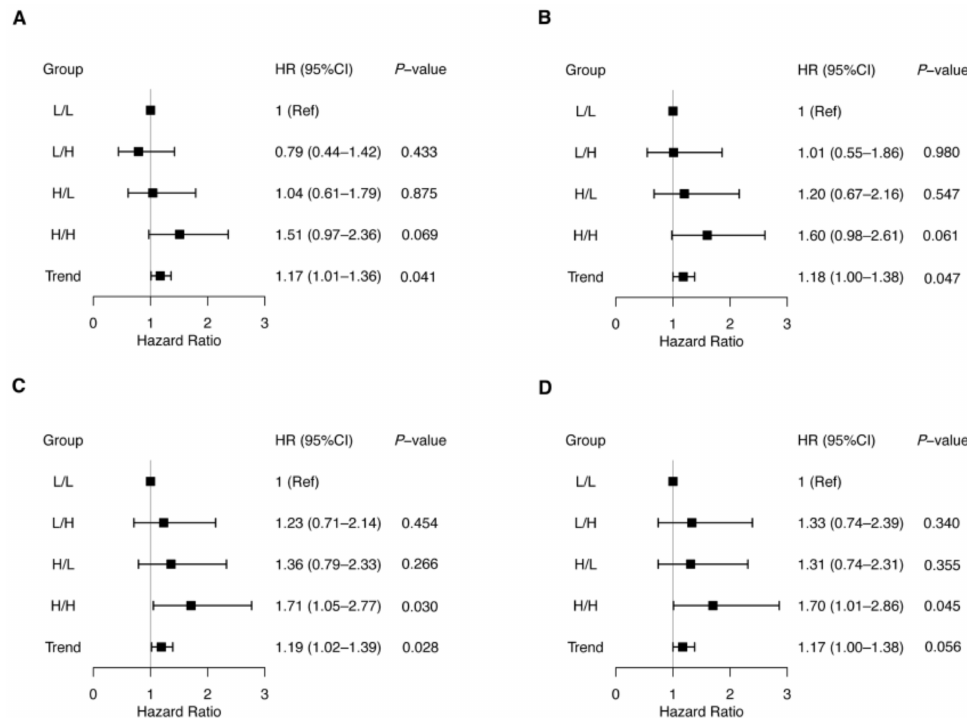
Figure 2. Forest plot of hazard ratios for major adverse cardiovascular events in groups according to trimethylamine N-oxide (TMAO) ( A , B ) and choline ( C , D ) levels at enrollment (V1) and follow-up visit (V2). Patients with available TMAO and choline levels of V1 and V2 were divided into four groups according to the median levels of each visit (TMAO: 6.7 µ mol/L and 12.7 µ mol/L, choline: 1.2 µ mol/L and 1.7 µ mol/L for V1 and V2, respectively). L/L, low V1 and low V2; L/H, low V1 and high V2; H/L, high V1 and low V2; H/H, high V1 and high V2. Cox proportional hazards regression was used to compare the risk of major adverse cardiovascular events among the four groups of patients using L/L as the reference on each occasion [( A , C ) unadjusted, ( B ) adjusted with age, hypertension, diabetes, peripheral artery disease, chronic kidney disease, and previous history of stroke and MI, Killip II-IV, the Global Registry of Acute Coronary Events risk score, multiple vessels disease, percutaneous coronary intervention, and the peak value of cardiac troponin I and N-terminal pro-B-type natriuretic peptide during hospitalization, as well as estimated glomerular filtration rate and left ventricular ejection fraction at V2; ( D ) adjusted with these factors and TMAO levels at V2]. We also grouped the 509 patients based on the median betaine, choline, and L-carnitine levels. As for choline, the median levels of V1 and V2 were 1.2 µ mol/L and 1.7 µ mol/L, respectively. These groups were comprised of L/L group ( n = 147), L/H group ( n = 107), H/L group ( n = 107), and H/H group ( n = 148). After adjusting for confounders and TMAO levels at V2, no statistical significance of MACE risk was seen in the L/H and H/L groups compared to the L/L group (HR 1.33, 95% CI: 0.74–2.39; p = 0.340 and HR 1.31, 95%